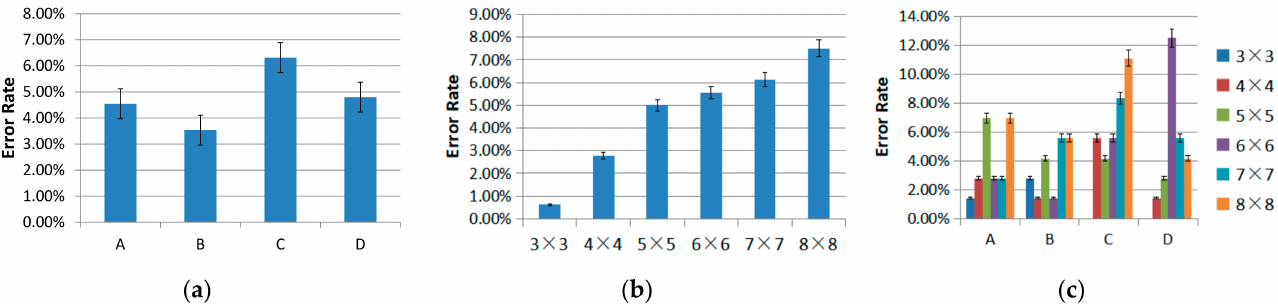
Figure 10. The error rate of Experiment 2. The error bars represent a 95% confidence interval: ( a ) average error rate with different regions; ( b ) average error rate with different target size levels; ( c ) average error rate for different target size levels under different regions (A, B, C, and